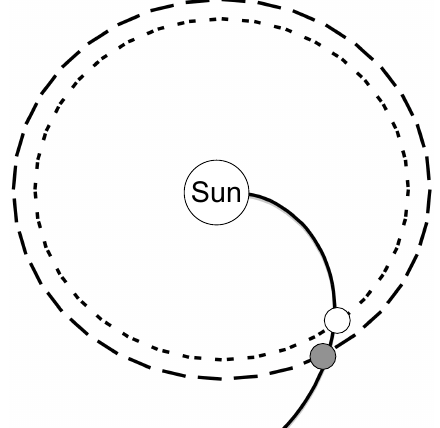
Fig. 3. Illustration of a solar wind stream in the idealized Carrington frame. The points at which the STEREO observatories intersect the stream are indicated with the small circles, open for AHEAD and filled for